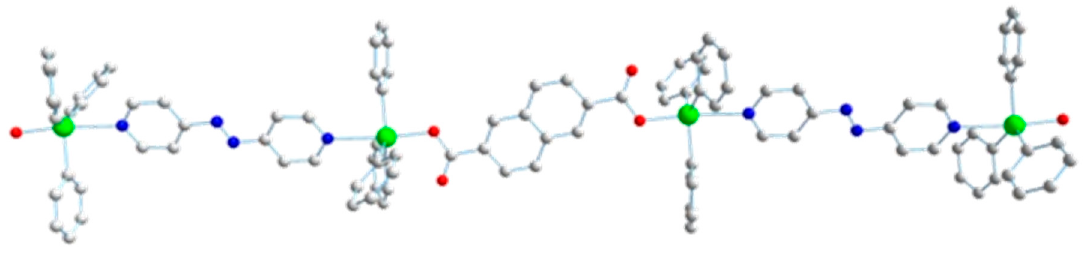
Figure 1. Molecular structure of compound 5 . Hydrogen atoms were omitted for